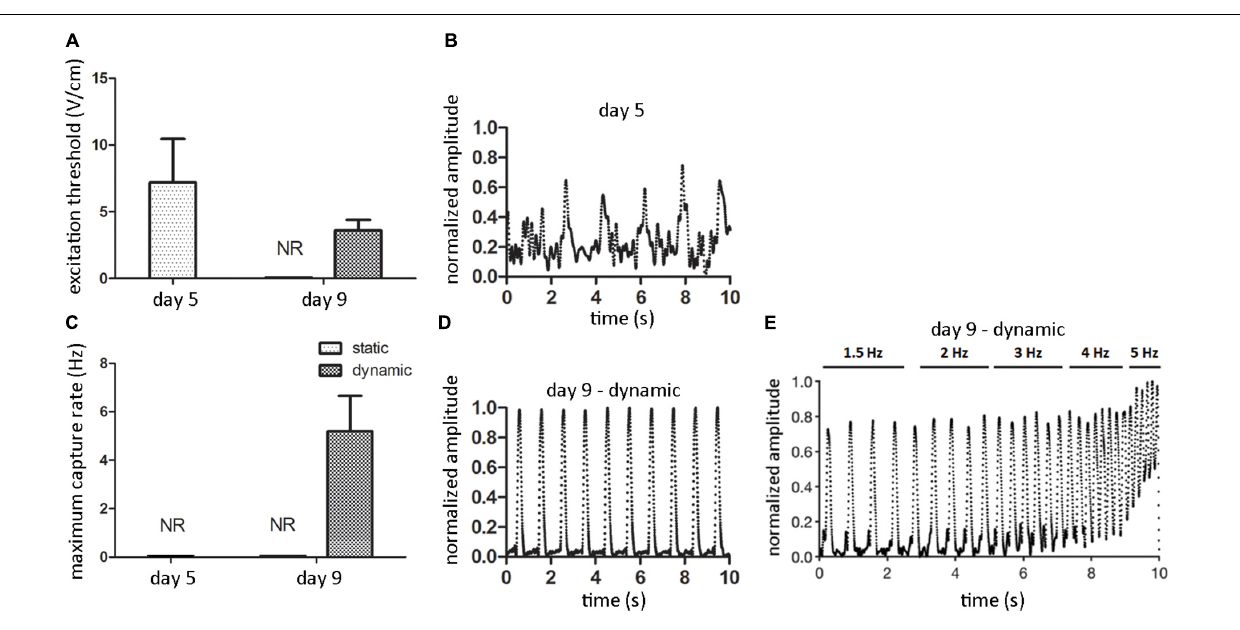
FIGURE 7 | ECT electrical functionality. Graphs showing the excitation threshold (ET, A ) and the maximum capture rate (MCR, C ) of ECTs at day 5 and following static and dynamic culture at day 9 (NR = not responding to external electrical pacing, n = 3). Explanatory reconstructions from video-recorded images of the contraction amplitude waveforms (normalized to the maximum peak value) of ECTs exposed to electrical pacing at day 5 (B) and following dynamic culture at day 9 (D) . (E) Explanatory reconstruction of the contraction amplitude waveform of day 9-dynamic cultured ECT exposed to electrical pacing at increasing